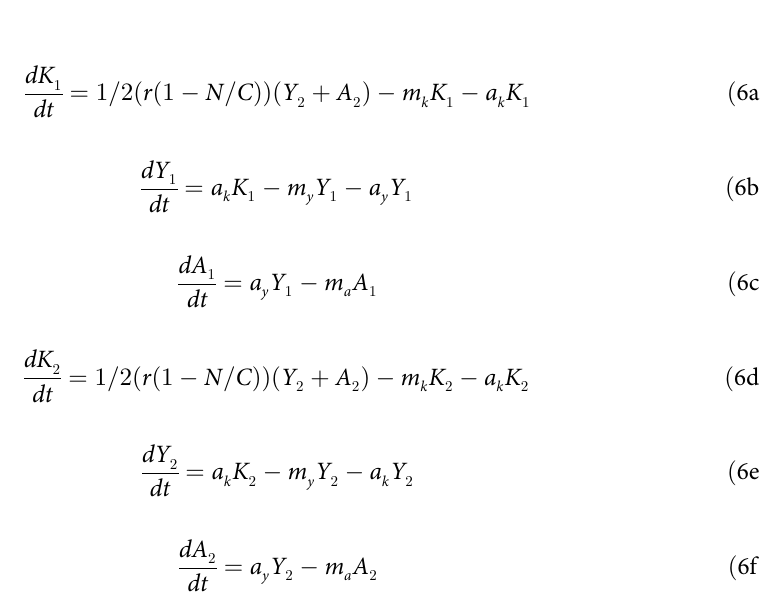
young, and 19.45% adults for each sex. Sex ratio is assumed 1:1 at birth and there are no sex differences in natural death